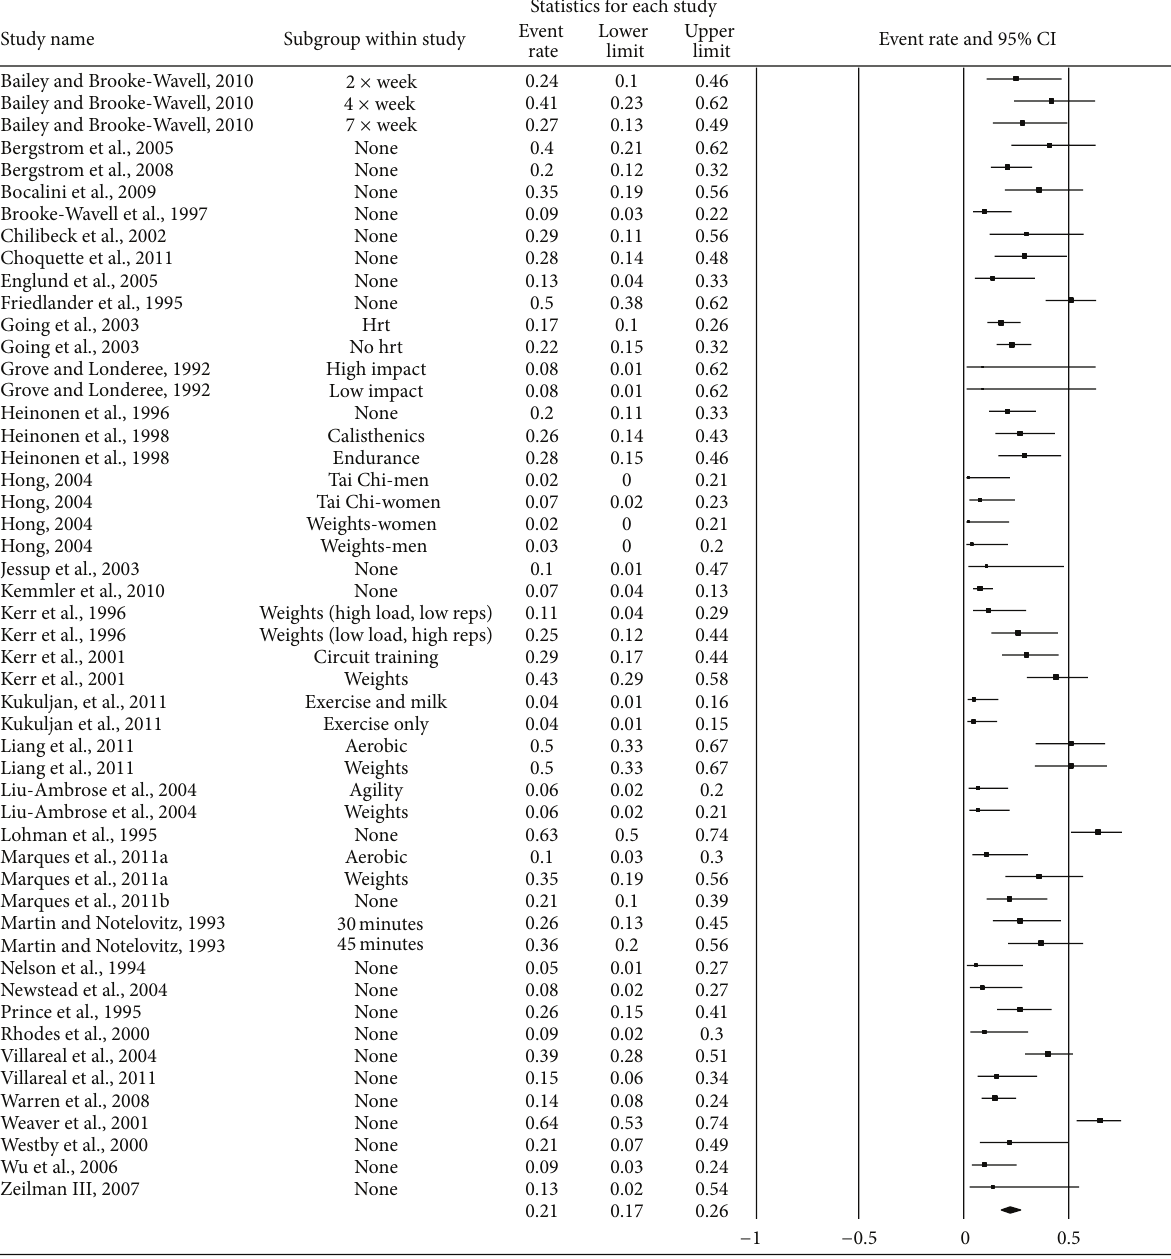
Figure 1: Forest plot for exercise dropouts (group level). Forest plot for exercise dropouts at the group level. The black squares represent the mean event rate while the left and right extremes of the squares represent the corresponding 95% confidence intervals. The middle of the black diamond represents the overall mean event rate while the left and right extremes of the diamond represent the corresponding 95% confidence